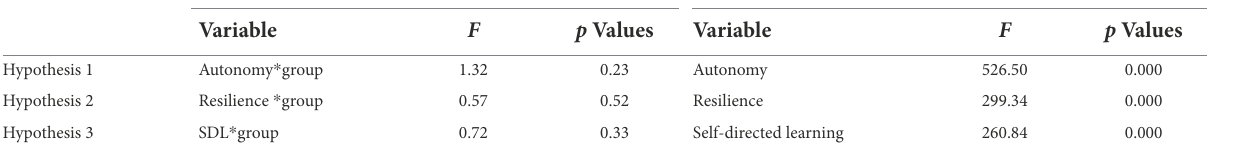
TABLE 4 Reception of homogeneous regression